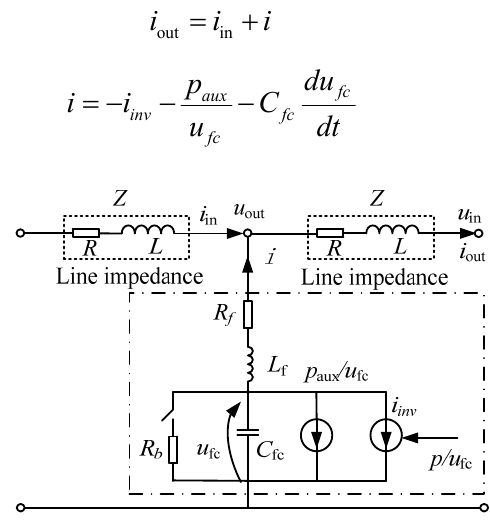
Figure 3. Train model.